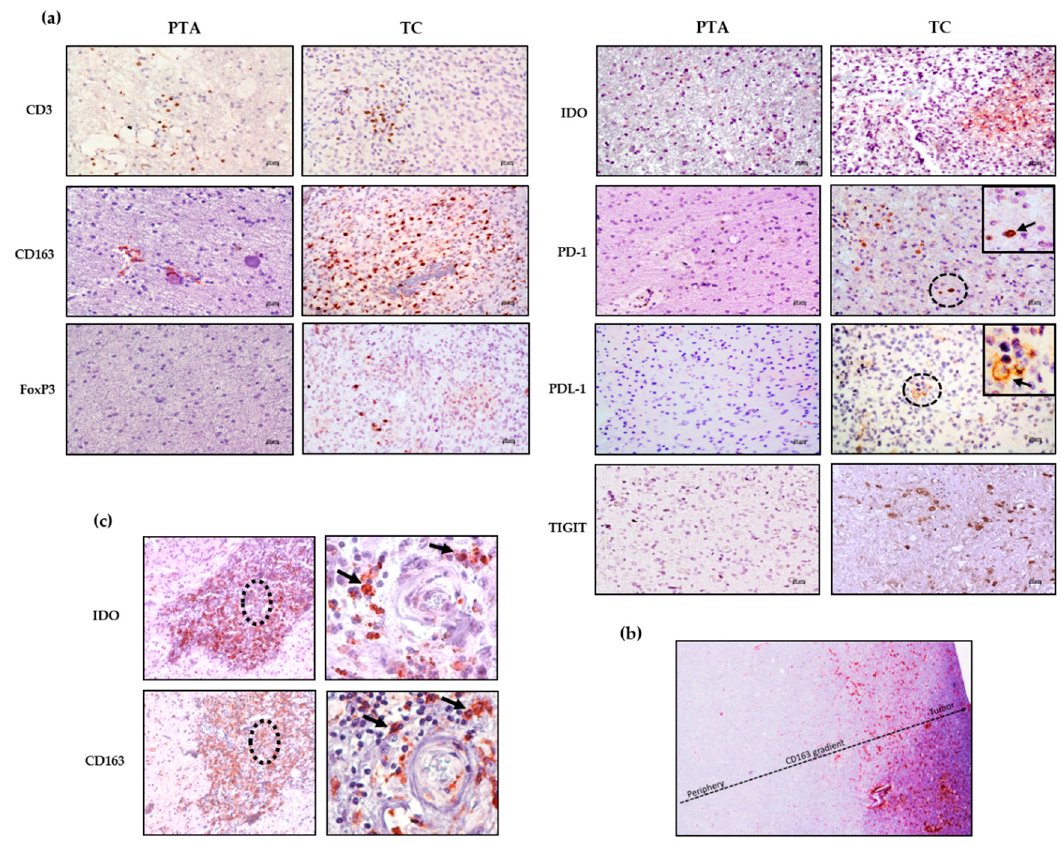
Figure 2. Immune infiltrate distribution in periphery tissue and tumor core of GBM samples. ( a ) Representative expression profile of immune infiltrate as characterized by CD3, FoxP3, PD-1, PDL-1, CD163, IDO and TIGIT in the tumor periphery of GBM (PTA) and tumor core (TC). Magnification, 20 × (bar = 20 µ m). Detailed images of PD-1- and PDL-1-positive cells in TC are shown (magnification, 40 × ). ( b ) CD163 positivity gradient from the periphery to the tumor core. CD163 + cells increase from the periphery to the tumor core, where they accumulate. The dotted arrow represents the increase in CD163 positive cells from the PTA to TC (magnification, 4 × ). ( c ) IDO and CD163 expression in GBM05 tumor core sample. Left panels are at 10 × magnification; dotted circles identify the perivascular area positive for and IDO and CD163 staining, enlarged in the right panels (40 × magnification).